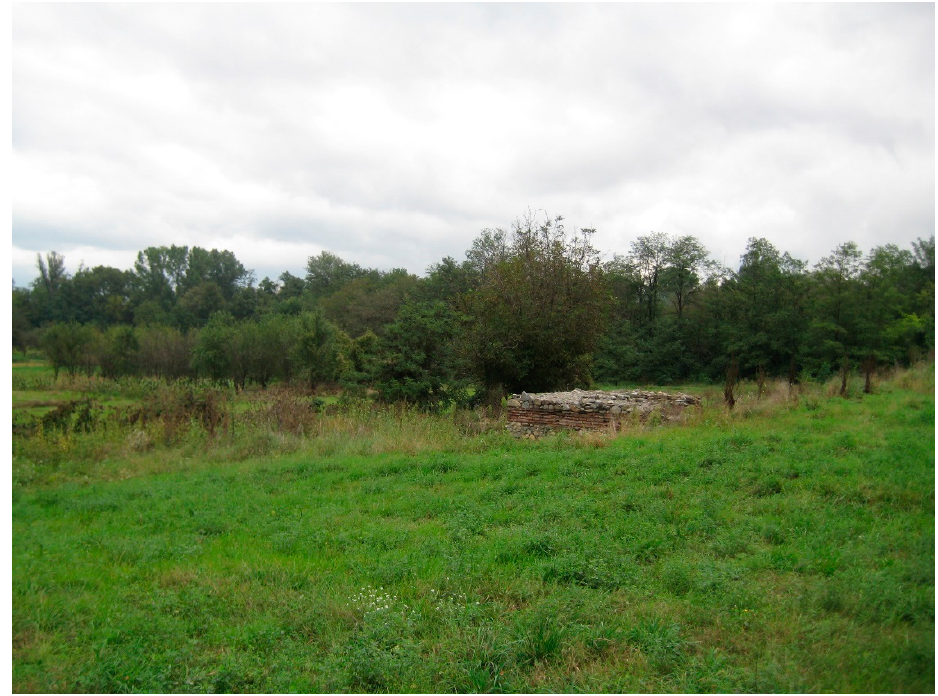
Figure 5. View from the western side of the north-eastern angle tower of the military camp of Timacum Minus—the area of the northern baths at the Beli Timok in the background (photo by L. Diers). The civilian settlement of Timacum Minus is further delineated by its necropolises.